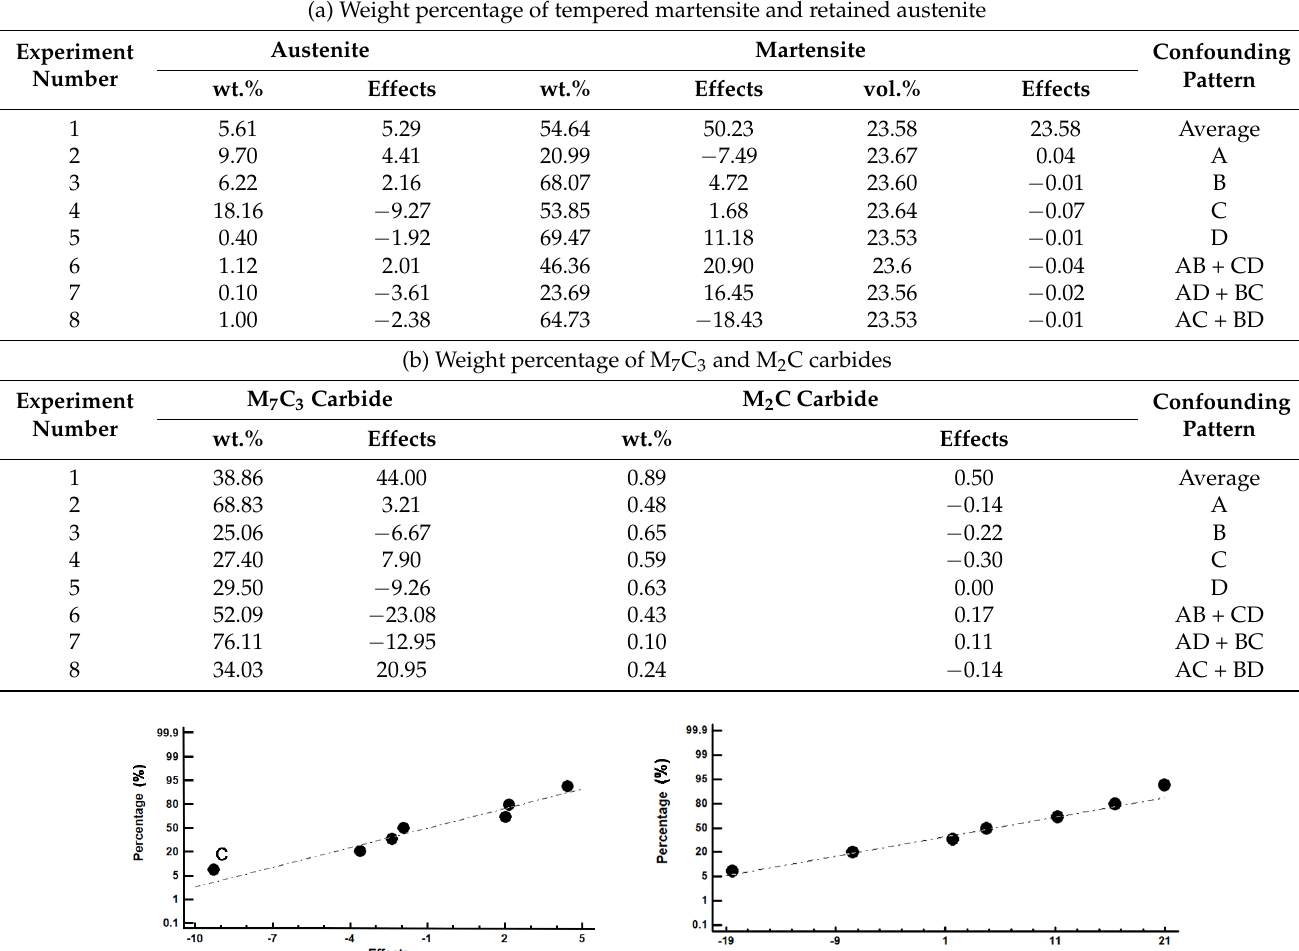
Table 5. Average values and obtained effects for the precipitated phases.